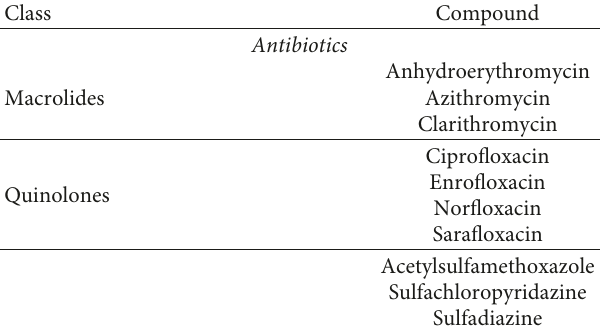
Table 1: Target pharmaceuticals used for establishing the ion ratio